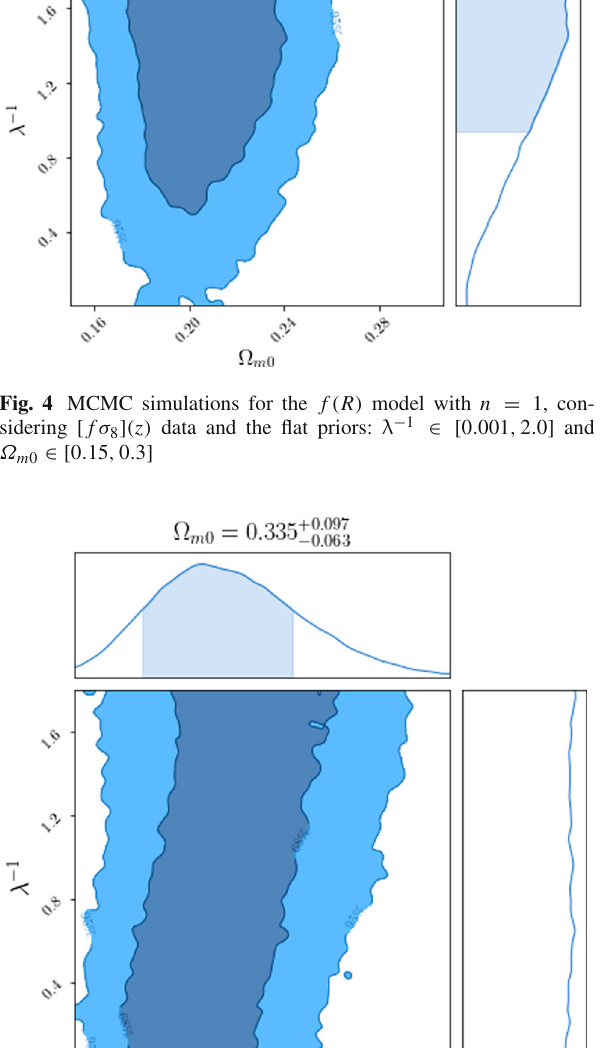
cal observables as a way to break the degeneracy of DE and MG models, also allowing to recognize the redshift regime where the tested model most affects the growth of cosmic